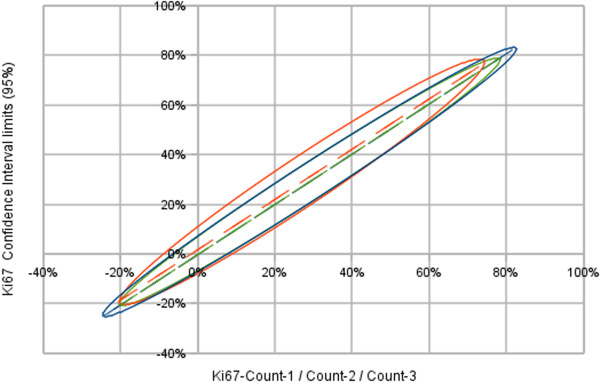
The ellipses computed from the limits of the confidence interval (CI 95%) for the three independent Ki67 counts (n = 30). Observer ellipses are almost superimposed: Ki67-Count-1 limit is the blue ellipse (centre x = 29%, y = 29%; major axis = 76%; minor axis = 6%; tilt = 45.36°); Ki67-Count-2 limit is the orange ellipse (centre x = 27%, y = 29%; major axis = 68%; minor axis = 8%; tilt = 46.38°); Ki67-Count-3 limit is the green ellipse (centre x = 29%, y = 29%; major axis = 70%; minor axis = 6%; tilt = 45.37°).